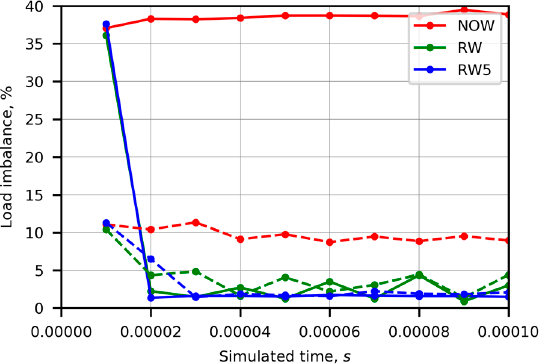
Figure 6. Time evolution of load imbalance when memory stress test was performed on one (the solid curves) and four (the dashed curves) co-located containers in Case 5. solid curves) and four (the dashed curves) co-located containers in Case 5.